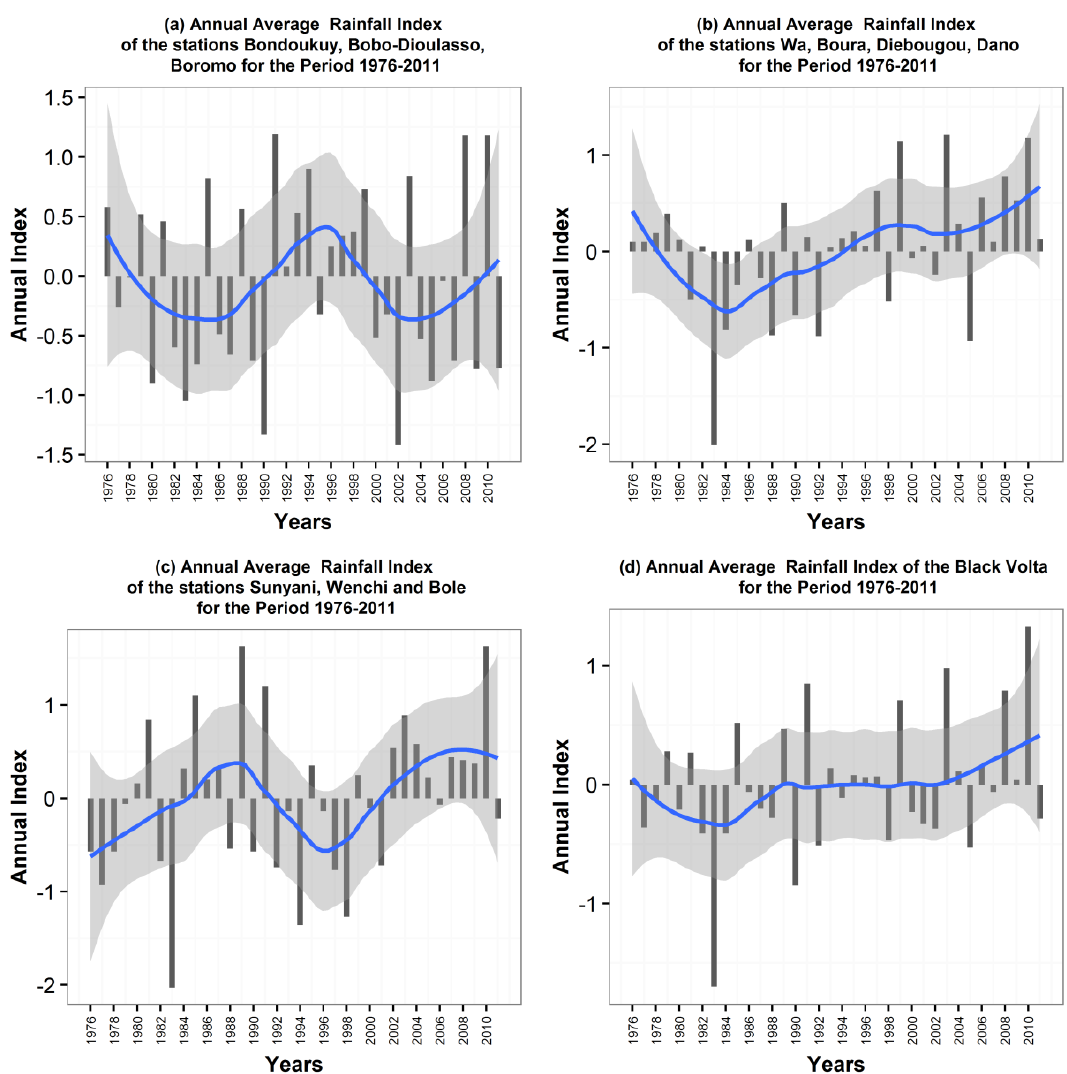
Figure 5. Annual Precipitation Index. The blue line or regression line represents a smoother (mean of Precipitation index at each year). The grey band is the display of confidence interval (95% confidence interval) around the smoother. This helps to see the overall trend in the precipitation index.